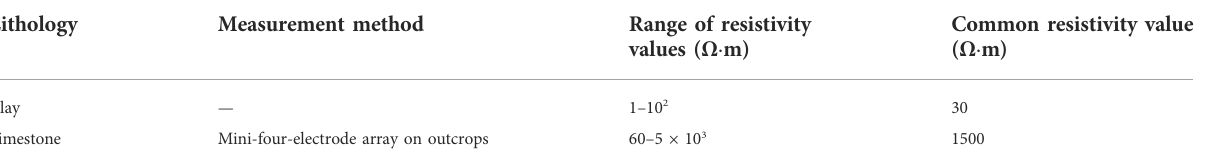
TABLE 1 List of rock electrical